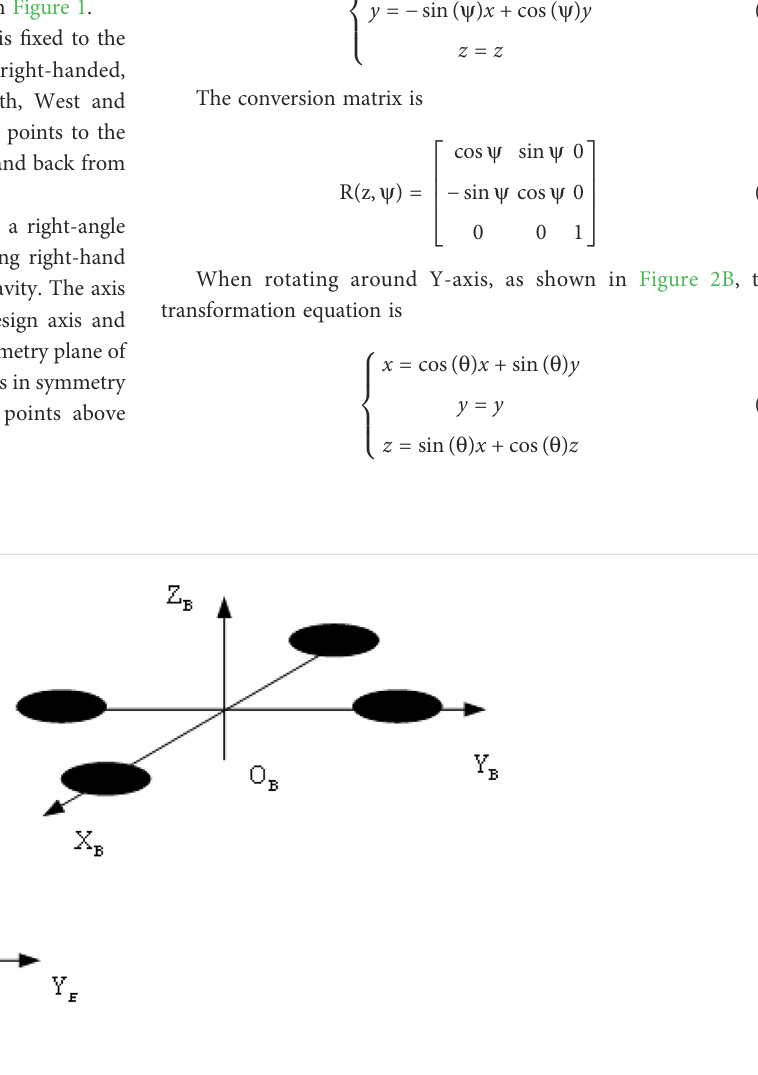
FIGURE 1 Inertial coordinate system and body coordinate